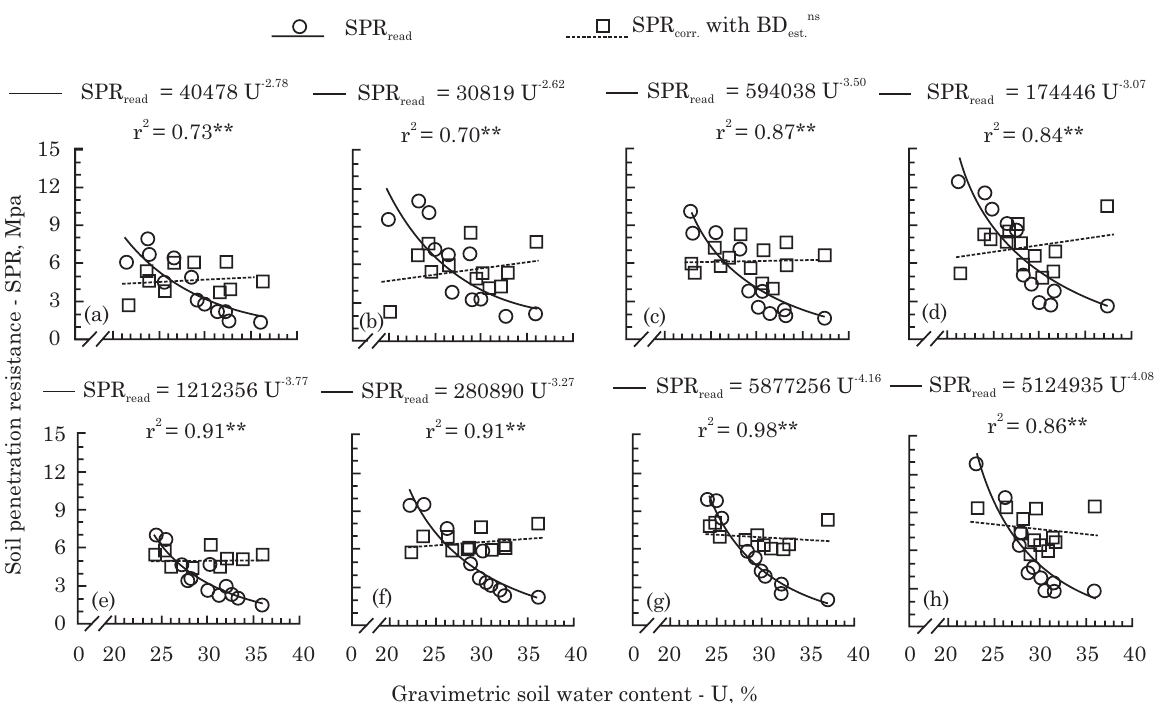
Figure 5. Variation of soil penetration resistance read in the field (SPR read ) and corrected (SPR corr ) with the gravimetric soil water content, in a Rhodic Eutrudox at different compaction levels, in the 5.5-10.5 cm layer: a) 1.13 Mg m -3 ; b) 1.30 Mg m -3 ; c) 1.30 Mg m -3 ; d) 1.33 Mg m -3 ; and in the 13.5-18.5 cm layer: e) 1.22 Mg m -3 ; f) 1.28 Mg m -3 ; g) 1.29 Mg m -3 ; h) 1.31 Mg m -3 . Original data obtained by Torres & Saraiva (1999). **Statistically significant equations (F test, p<0.01); ns